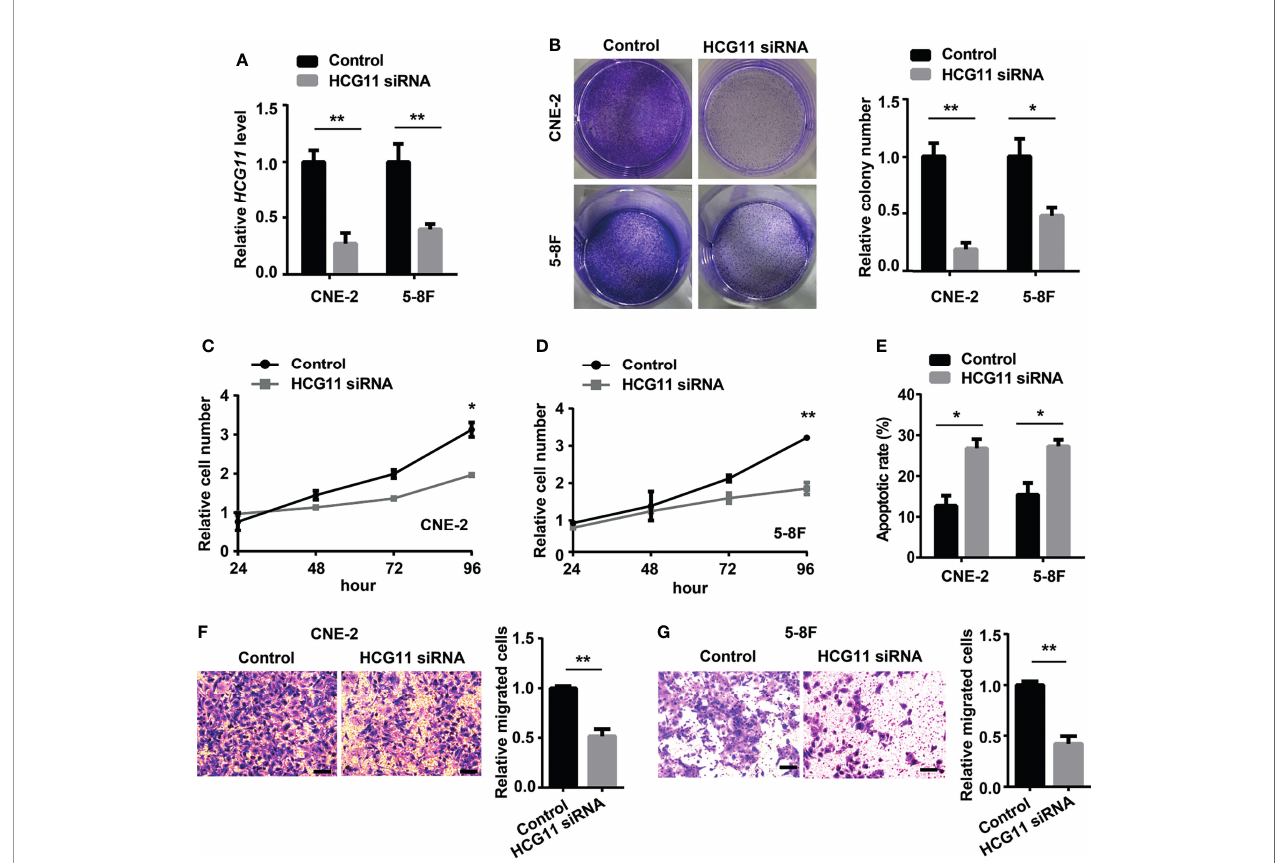
FIGURE 3 | HCG11 silencing suppresses proliferation and migration in NPC cells. (A) QPCR analysis of HCG11 expression in 5-8F and CNE-2 cells transferred with control or HCG11 siRNA. (B – D) Proliferation capacity of 5-8F and CNE-2 cell lines transferred with control or HCG11 siRNA was con fi rmed with colony formation (B) and CCK8 assay (C, D) . (E) Flow cytometry analysis of the apoptosis of 5-8F and CNE-2 cells transferred with control or HCG11 siRNA. (F, G) Transwell assay examined cell migration of 5-8F (F) and CNE-2 cells (G) transferred with control or HCG11 siRNA. Scale bar, 50 m m. Data were presented as Mean ± SEM. *p < 0.05, **p < 0.01. These experiments were repeated three